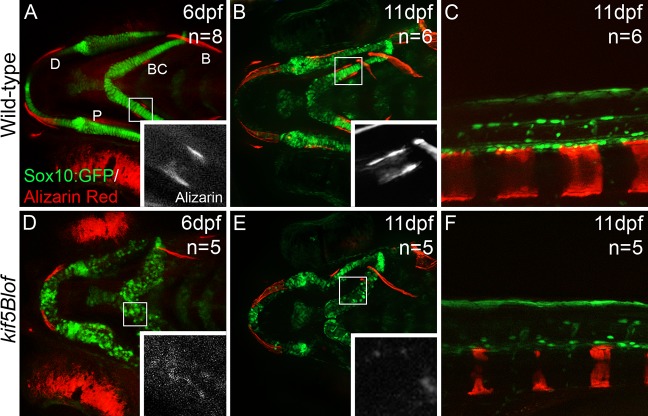
Impeded mineralization in kif5Blof.Confocal projections of images of live embryos at 6 dpf (A, D) and 11 dpf (B, C, E, F). GFP stained chondrocytes and Alizarin Red stained mineralized matrix. Intramembranous bones (MD, P and B) show mineralization but were shorter at 6 dpf (A, D). BC, the only endochondral bone at this stage, mineralization was deficient but evidence of mineralization is detectable (insets in D). At 11 dpf membranous and perichondral ossification had progressed in Wt (B) and vertebraes were apparent (C). In kif5Blof membranous ossification had also progressed (E) and vertebraes were mineralized (F). However, perichondral ossification was defective as indicated by the absence of BC (E). B: branchiostegal; BC: bone collars; P: entopterygoid; D: dentary.